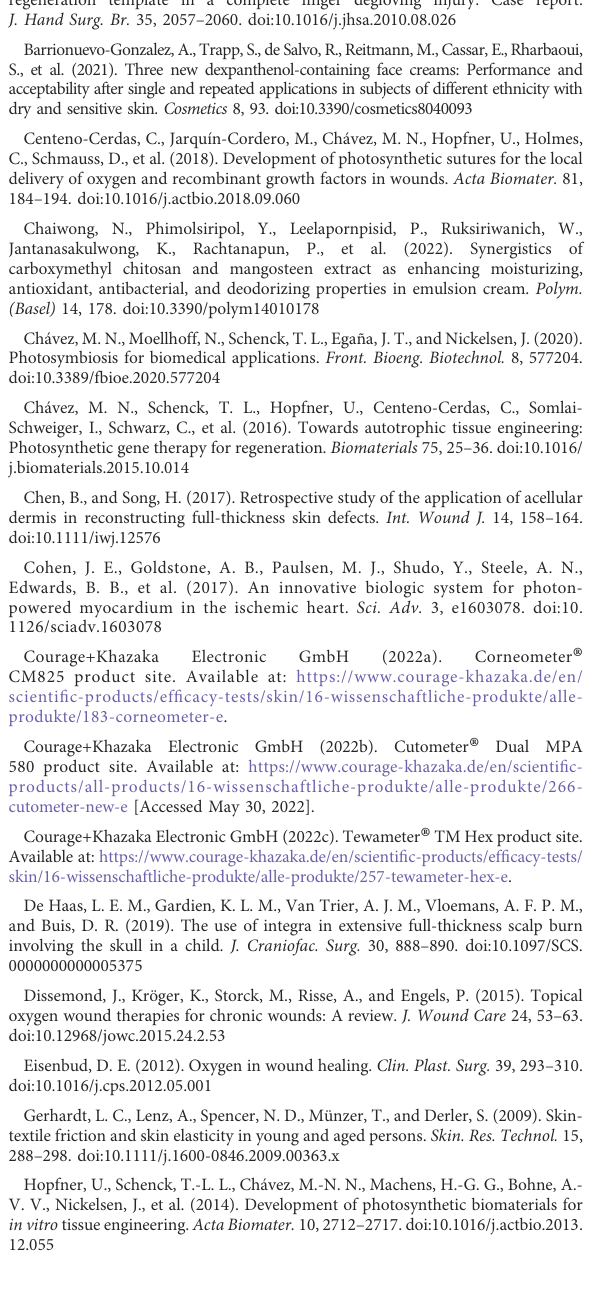
sensation (C) , ranging from 0 to 3, smell associated with the implanted photosynthetic scaffold (D) , ranging from 0 to 3, and light annoyance related to the illumination device (E) , ranging from 0 to 3. Illumination device was removed from the patient after day 7. Data extracted from (Obaíd et al.,